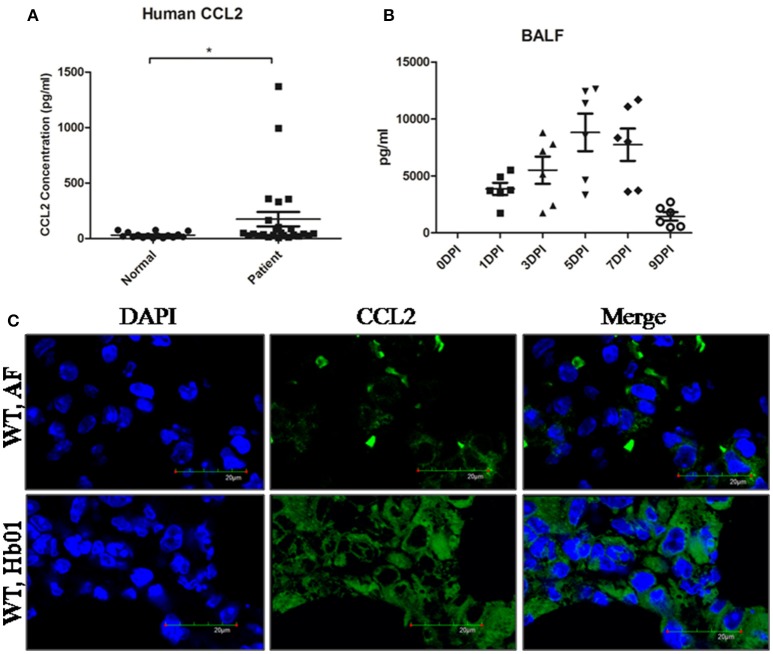
CCL2 levels were significantly increased in the serum of H7N9-infected patients and the BALF and lung tissues of Hb01-infected mice. The serum concentration of CCL2 of H7N9-infected patients (n = 29) was determined using a Bio-Plex Human Cytokine 25-Plex array (Bio-Rad Laboratories) (A). Four-week-old B6 mice were anesthetized and inoculated with 103 TCID50 Hb01 virus. The level of CCL2 in BALF (B) was assayed using a Mouse Cytokine 23-Plex Array (Bio-Rad Laboratories) at the indicated time points. (C) The CCL2 level in mouse lung tissue at 5 days after Hb01 infection was evaluated by fluorescence microscopy. CCL2 was stained with Alexa Flour 488 (green) and nuclei were strained with DAPI (blue). *p < 0.05.